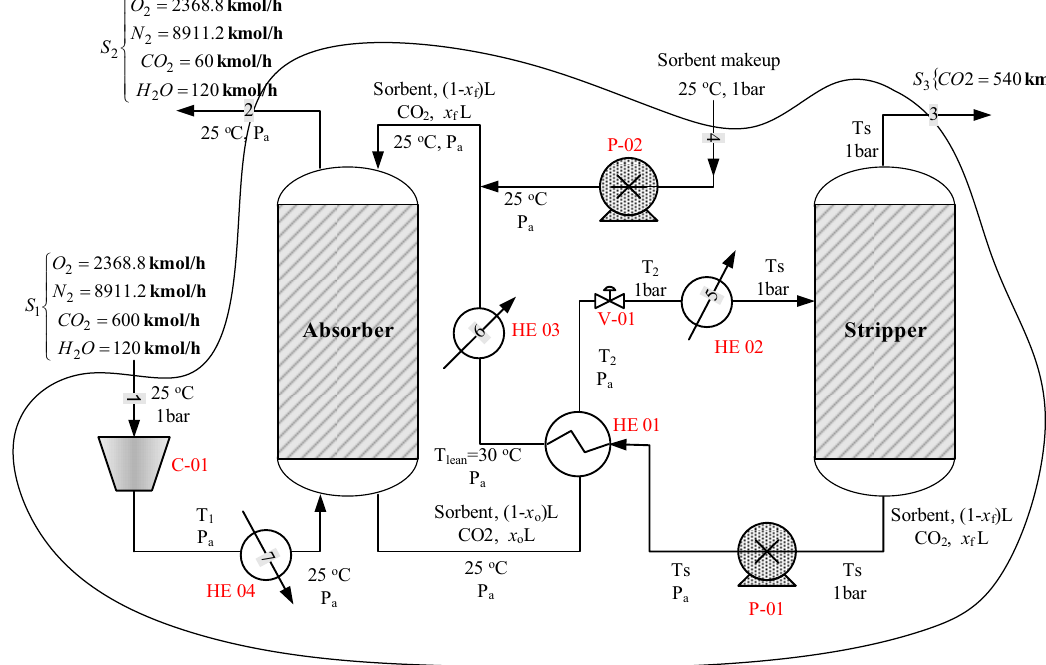
Figure 1: Schematic of CO 2 capture process using DES.